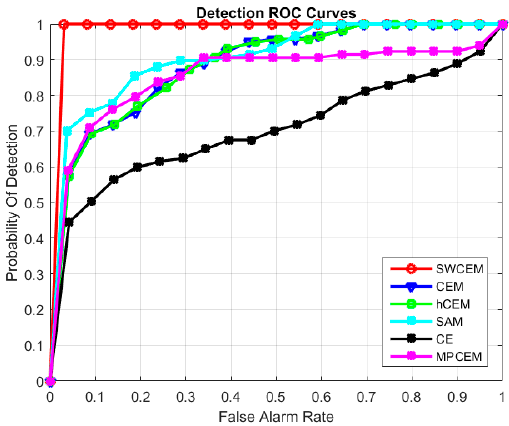
Figure 15. ROC curves of different methods on AVIRIS Dataset 2.